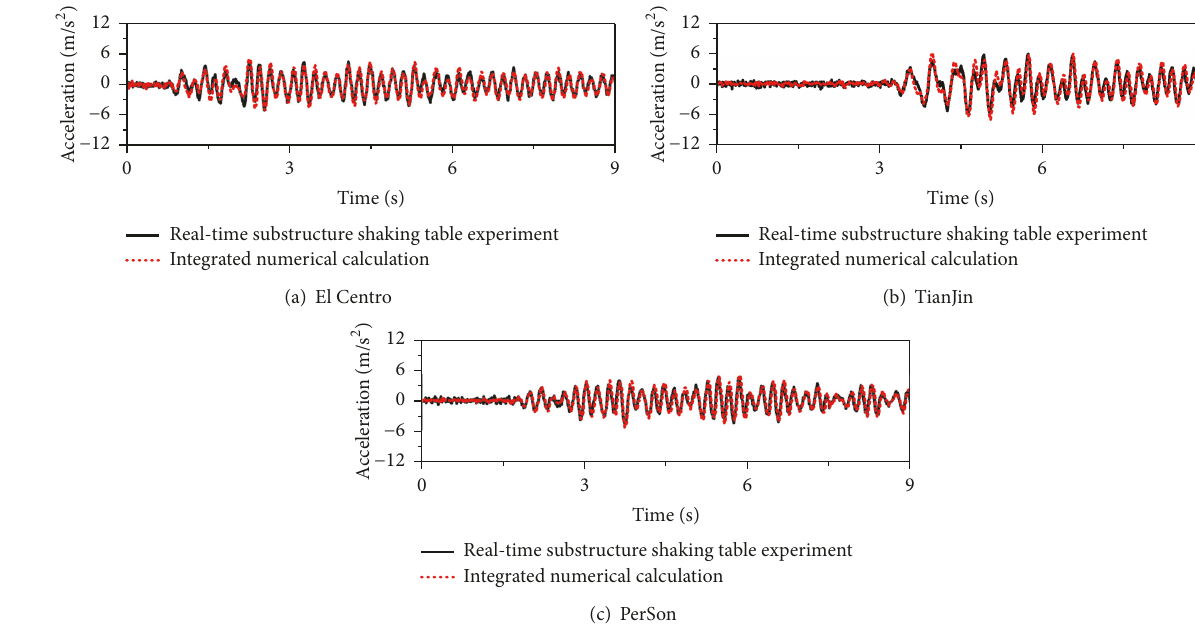
Figure 10: Experimental and numerical acceleration responses of the equipment